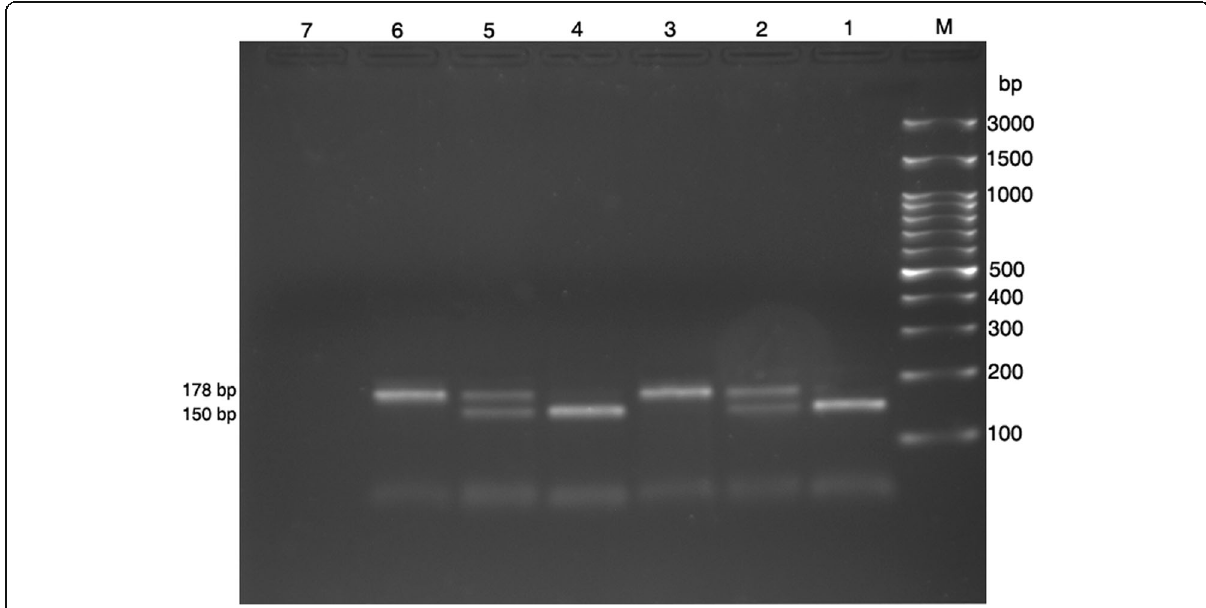
Fig. 2 Digestion products for KCNJ11- rs5219 by BanII enzyme. Samples were electrophoresed on a 2% agarose gel. Lane M: 100 bp ladder, Lane